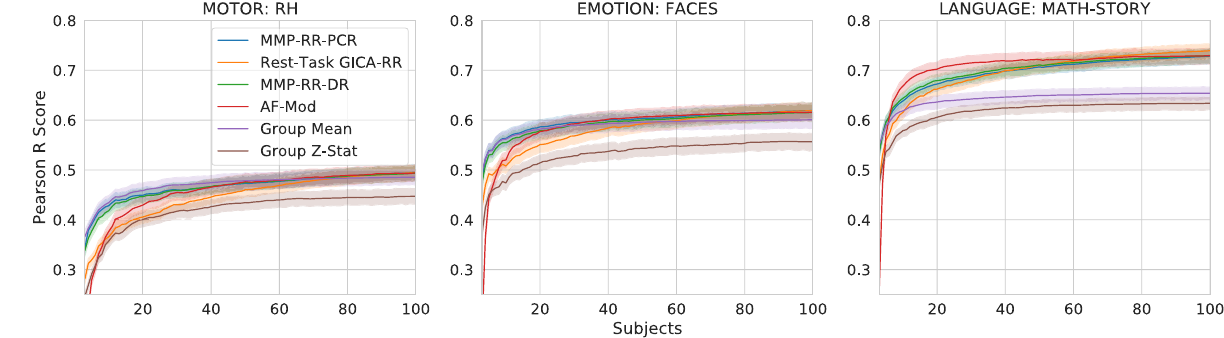
Figure 7. Subject-wise Pearson r score benchmark results for 3 selected (poor, mediocre, good), 4 high performing models ( MMP-RR-PCR , Rest-Task GICA-RR , MMP-RR-DR , AF-Mod ) and two baseline models ( Mean (Baseline) , Group Z-stat ). Poor (left): Motor-Right Hand; Mediocre (middle): Emotion: Faces; Good (right): Language: Math-Story. Experiment included 3–100 subjects for training. The group z-statistic baseline results are considerably worse than the group mean baseline. The 4 models largely resemble each other’s performance when sample sizes increase past 40 subjects.